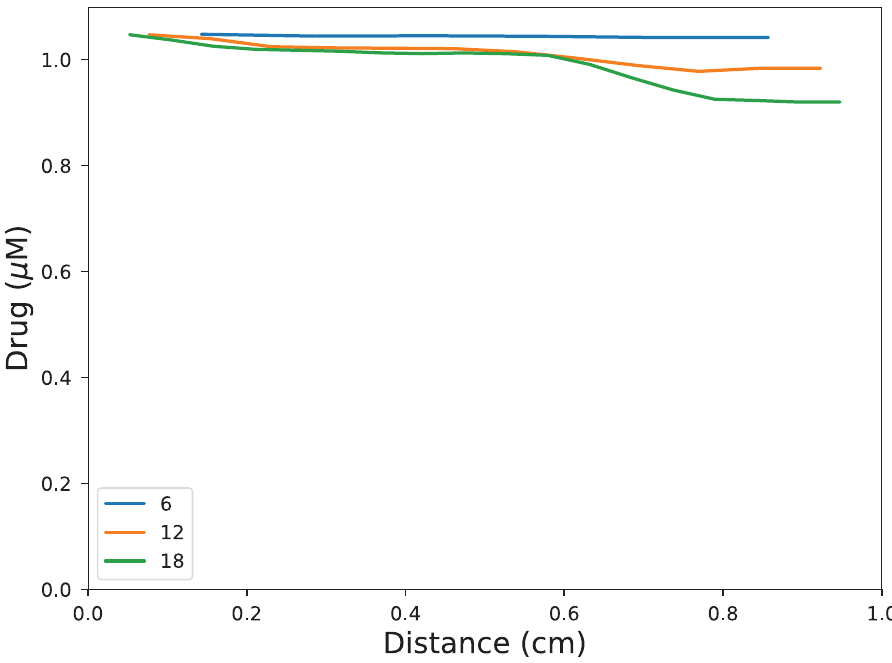
Fig 8. The drug concentration in the tissue as a function of the distance along the x -axis. The legend indicates the networks on which the steady states were found. The incoming drug concentration is v 0 = 5 μ M.